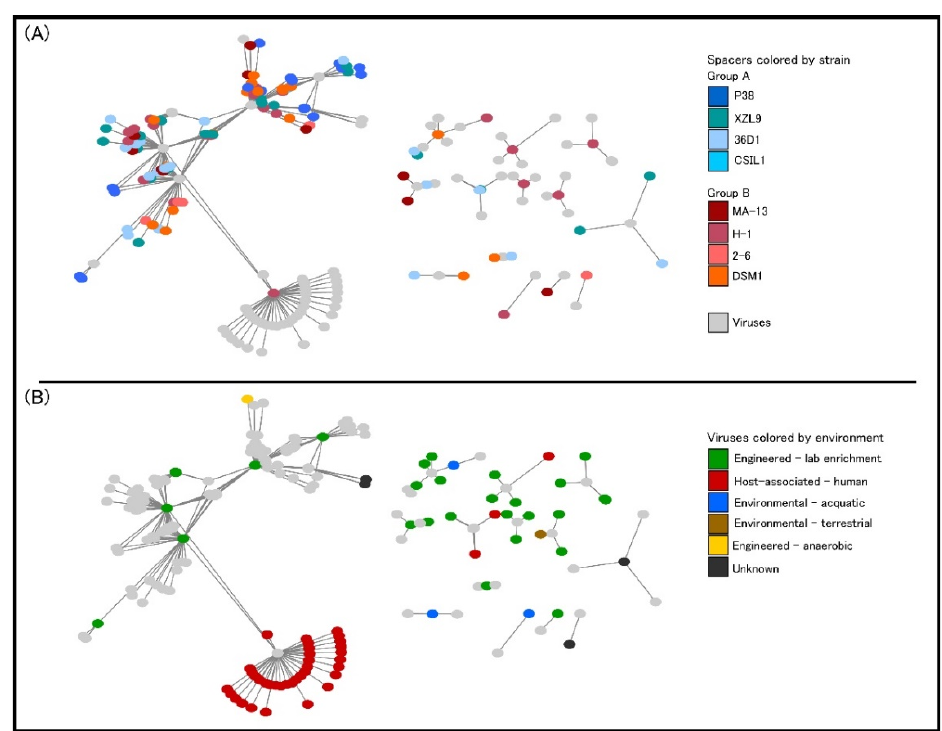
Figure 10. Graphical representation of interaction networks between spacers and viruses. Nodes represent spacers and virus sequences, with lines representing a match between them. ( A ) Spacer nodes colored by their strain of origin. ( B ) Virus nodes are colored by their ecosystem of isolation.